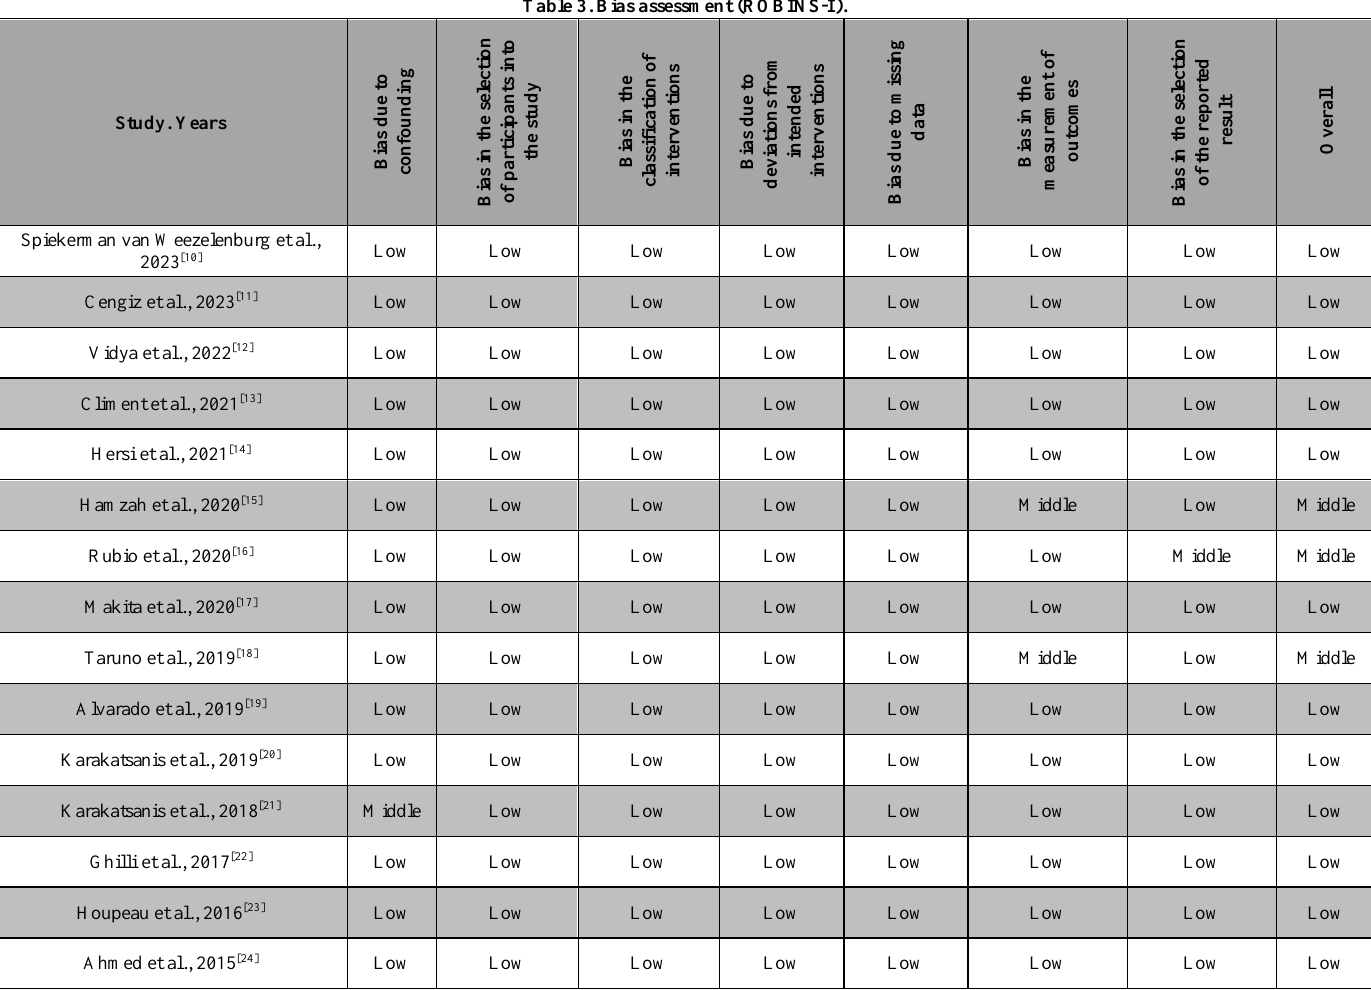
Table 3. Bias assessment